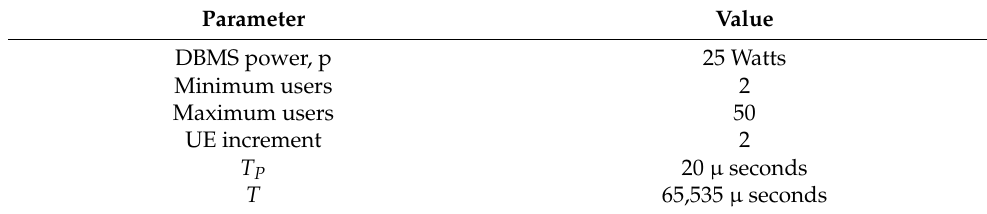
Table 4. Simulation parameters of each base station.